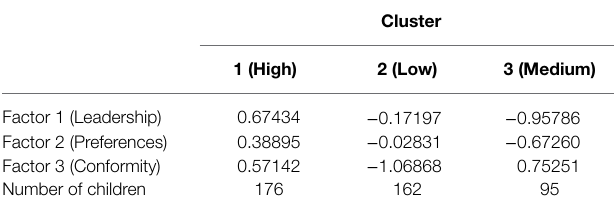
TABLE 5 | Final cluster